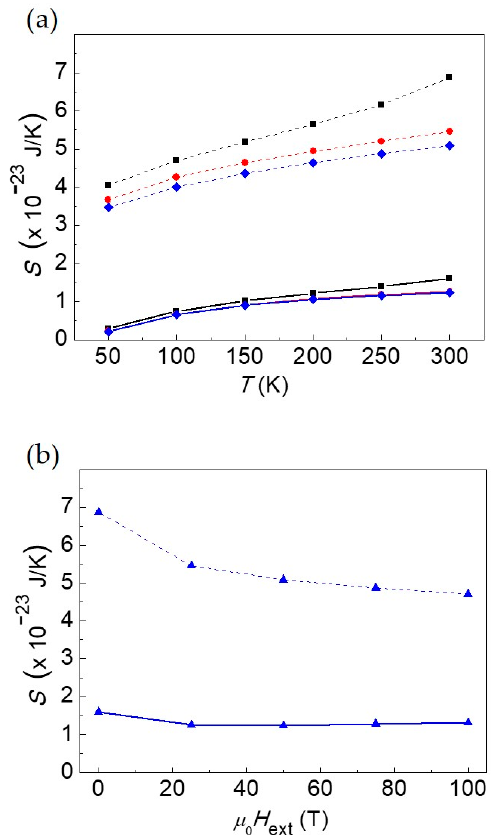
Figure 5. ( a ) Configurational entropy as a function of T for a 2D skyrmions distribution (solid lines) and for a 3D skyrmions distribution (from Figure 5 of [13]) (dashed lines) for µ 0 H ext = 0 mT (black lines); µ 0 H ext = 25 mT (red lines) and µ 0 H ext = 50 mT (blue lines); ( b ) configurational entropy as a function of the external bias field at T = 300 K for a 2D and for a 3D skyrmions population distribution (from Figure 5 of [13]). The meaning of the blue lines (solid and dashed) is the same as in panel ( a ). For the calculation of S 2D at µ 0 H ext = 75 mT ( µ 0 H ext = 100 mT) the following parameters were used: a = 12.45 × 10 − 5 J / m 2 ( a = 15.71 × 10 − 5 J / m 2 ) and D 0sky = 25.87 nm ( D 0sky = 22.51 nm).